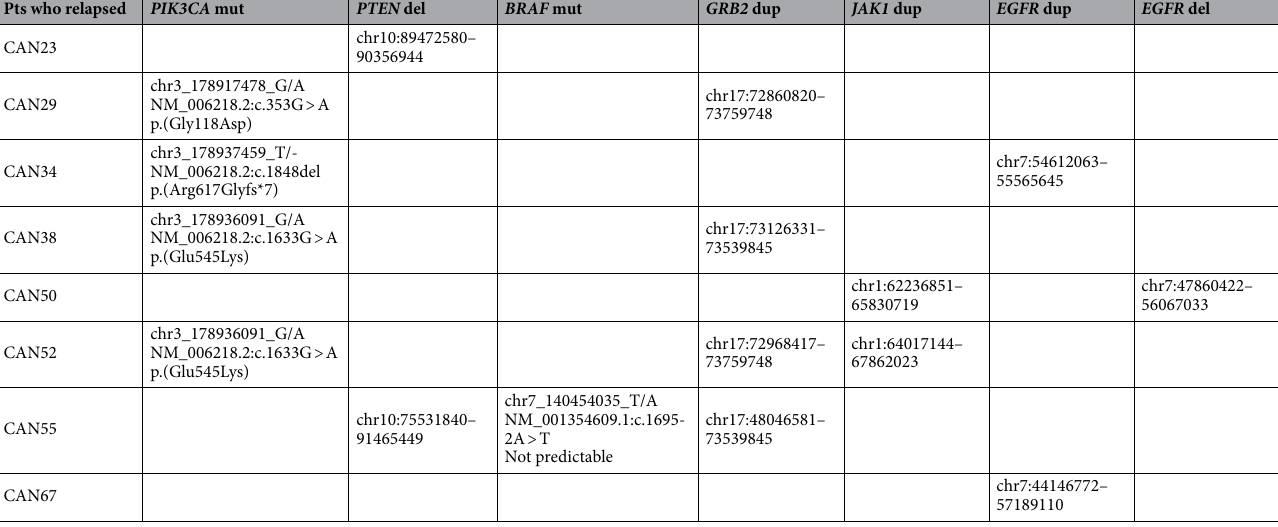
Table 2. Genetic variants in genes involved in the pharmacodynamics pathway of EGFR inhibitors and genetic variants in PTEN and BRAF , genes previously described in the literature as being related to the response to EGFR inhibitors.